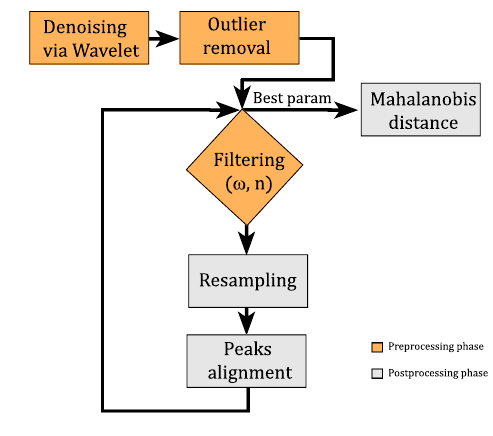
Figure 2. Flowchart of the signal processing